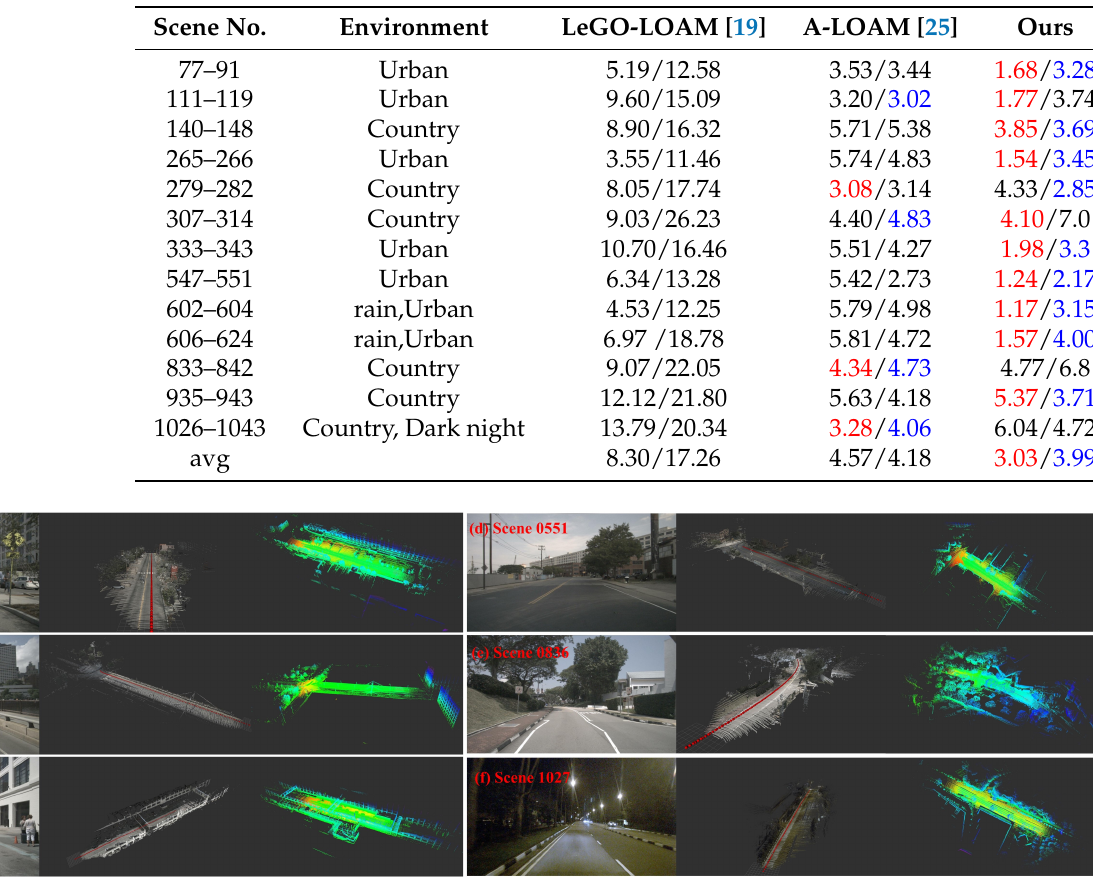
Table 3. Translation error [%]/rotation error [deg/100 m] comparison of the proposed DV-LOAM with existing methods on the NuScenes full dataset (v1.0) part 1. Best results in translational error/rotational error are highlighted in red and blue, respectively.